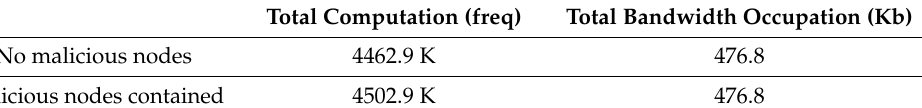
Table 6. The performance of the DPOS algorithm.